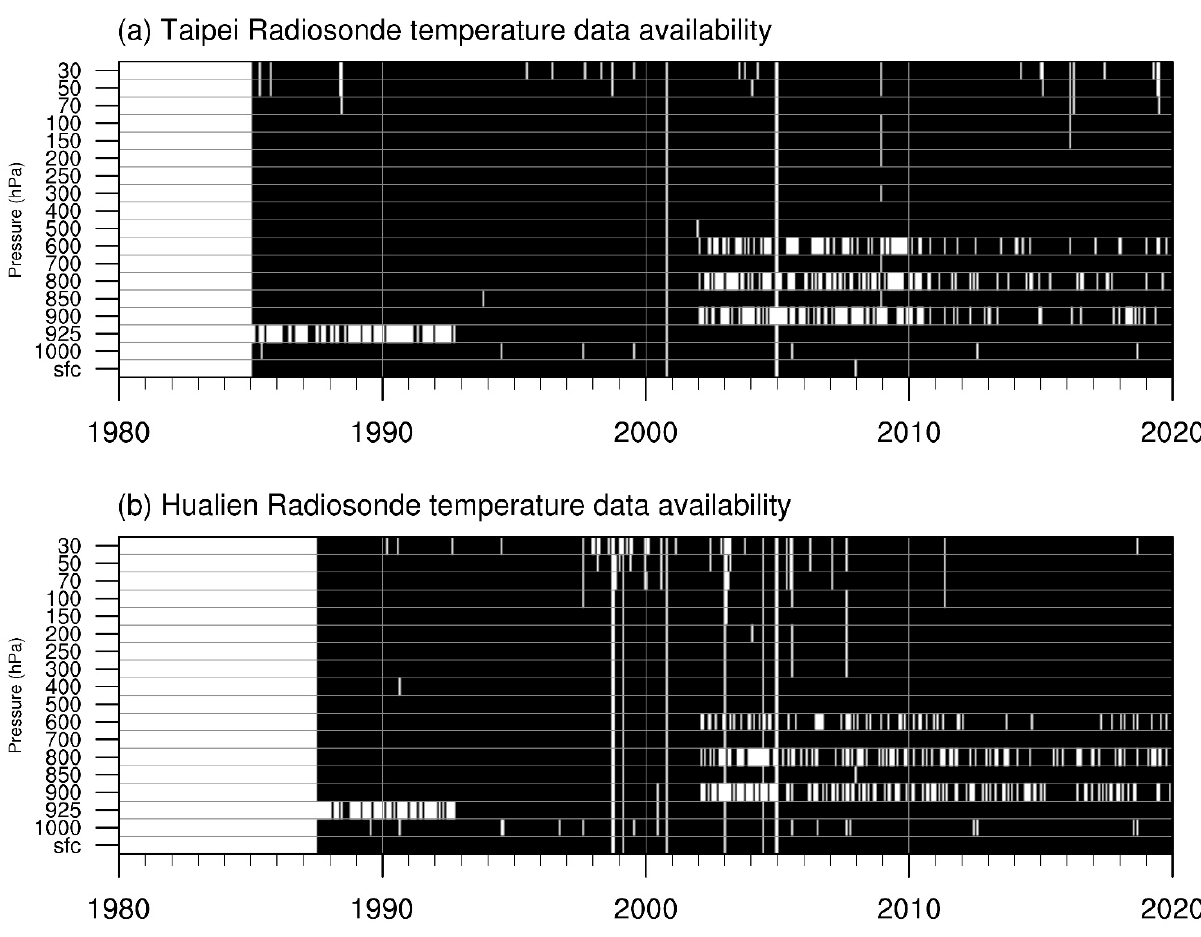
Figure 2. Radiosonde temperature data availability for every date at each pressure layer from the CWB ( a ) Taipei and ( b ) Hualien sounding stations. Black is marked for the date when the data are available.